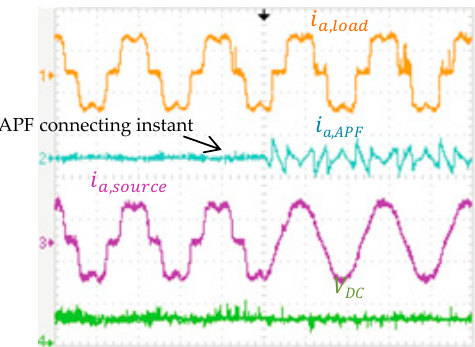
Figure 9. Experimental results at the transient condition; ( the orange color ) the load current wave form of phase A [Amp/div: 6 A and time/div: 10 ms], ( the blue color ) the APF current wave form of phase A [Amp/div: 6 A and time/div: 10 ms], ( the pink color ) the source current wave form of phase A [Amp/div: 6 A and time/div: 10 ms], ( the green color ) the DC link voltage [volt/div: 500 V and time/div: 10 ms].